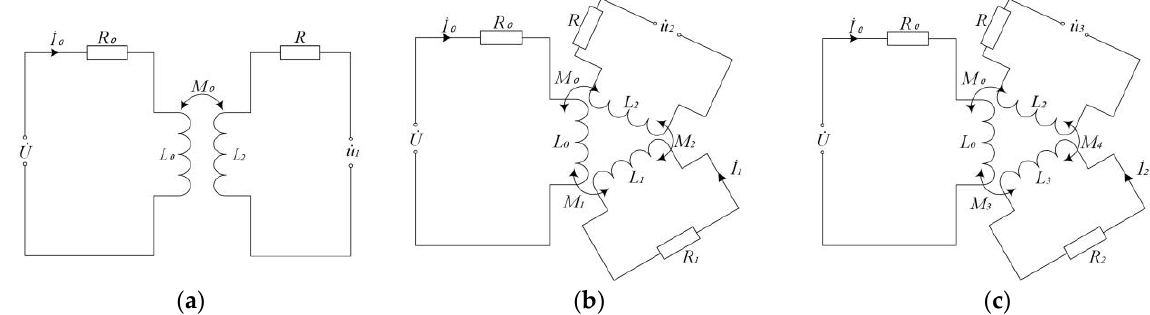
Figure 2. The equivalent circuit diagram: ( a ) no debris; ( b ) the test of ferrous debris; ( c ) the test of non-ferrous debris.